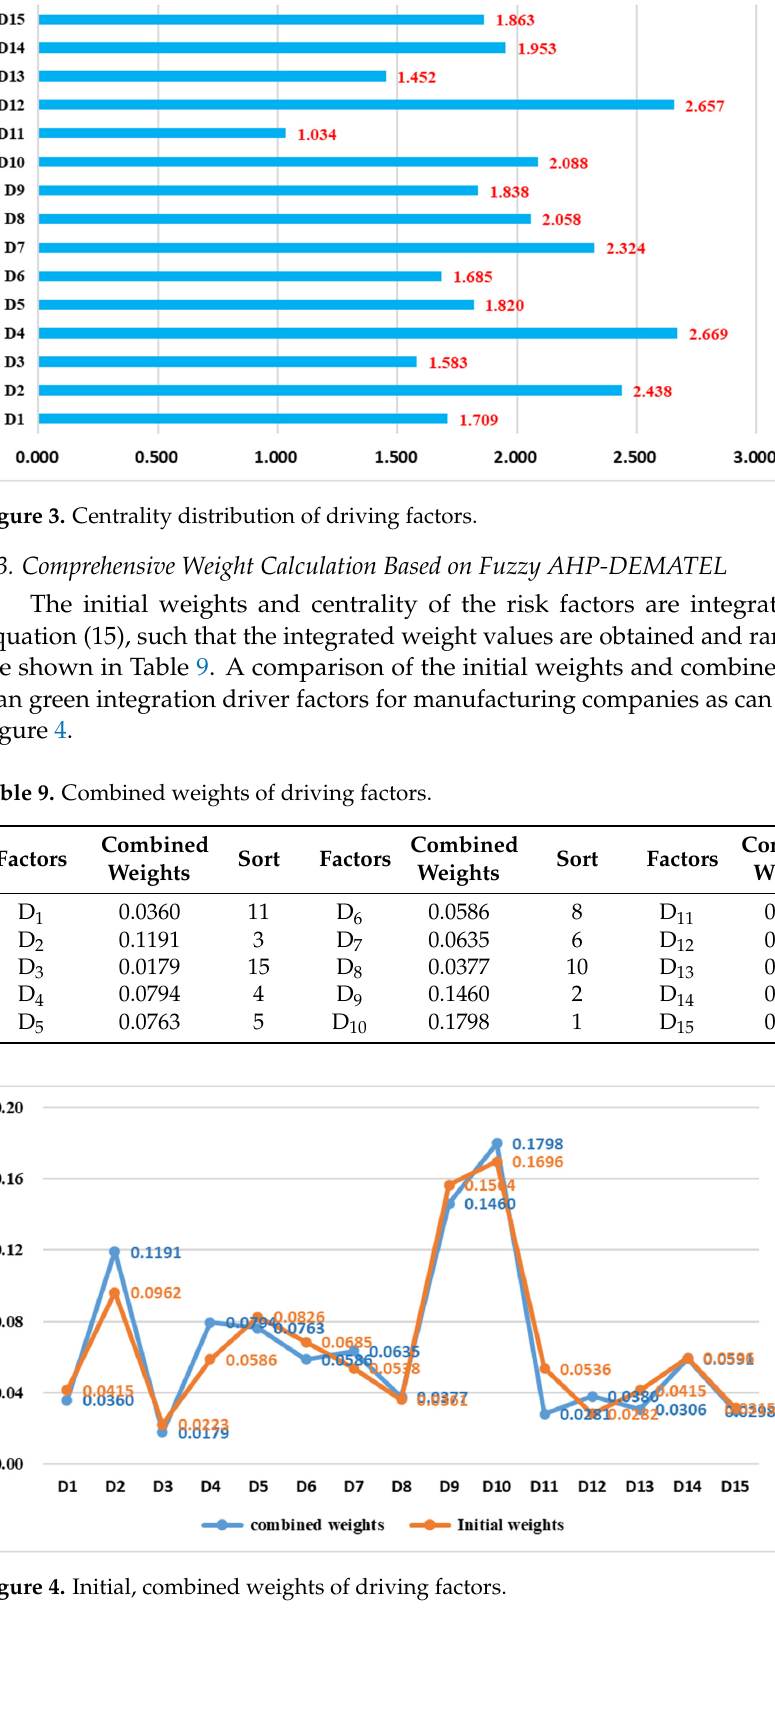
Figure 2. Distribution of cause degree of driving factors.